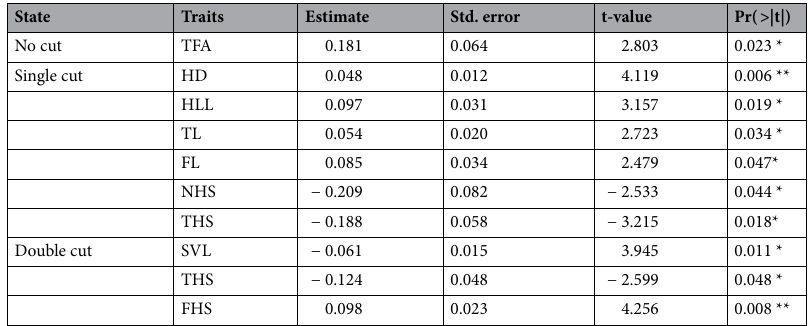
Table 3. Effect of morphology on the comprehensive score under the three states estimated using PLS. Estimate represents the regression coefficients for the traits on the comprehensive score. The standard error of the estimate (Std. Error), t values and probabilities (Pr( >|t|)) were estimated using the jack knife procedure in the pls package of R. Significance levels: * P < 0.05, ** P < 0.01.